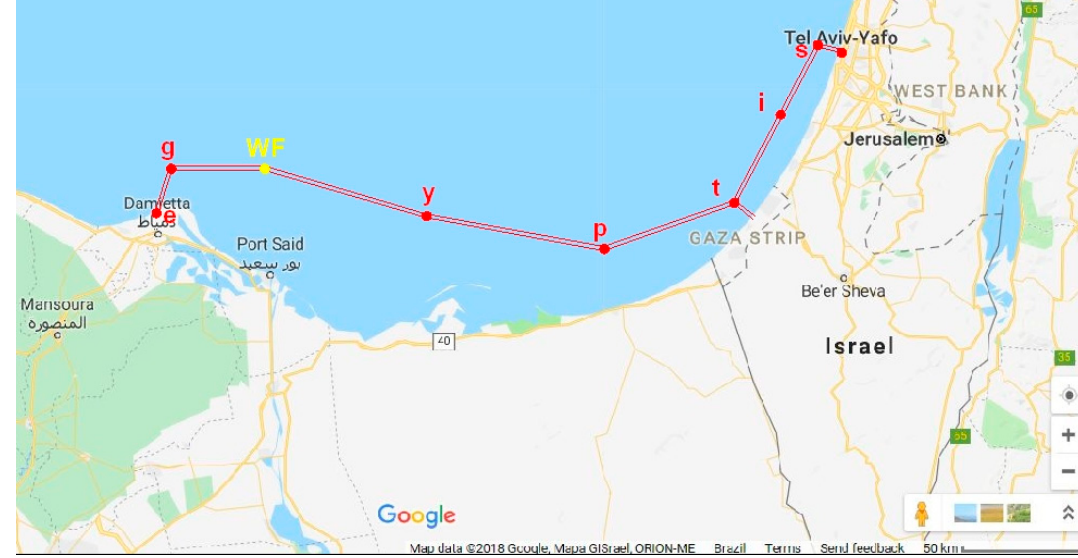
Figure 3. Location of the pipeline Nile/Tel Aviv, Israel and Gaza-Palestine; letters in bold mean pumping units. WF is the location of the wind power plant. Map source: [48].